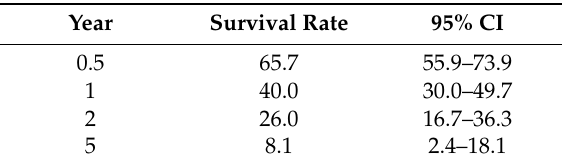
Table 4. Absolute survival rates at 0.5, 1, 2, and 5